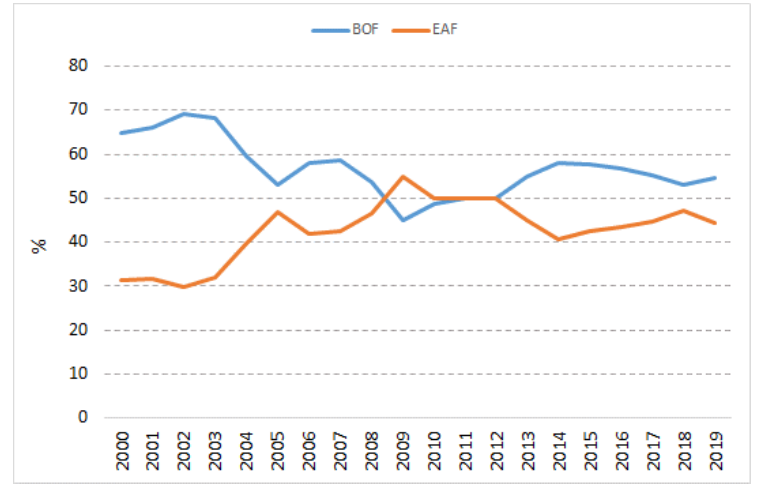
Figure 4. The share of electric arc furnace (EAF) and basic oxygen furnace (BOF) in total steel production in Poland.